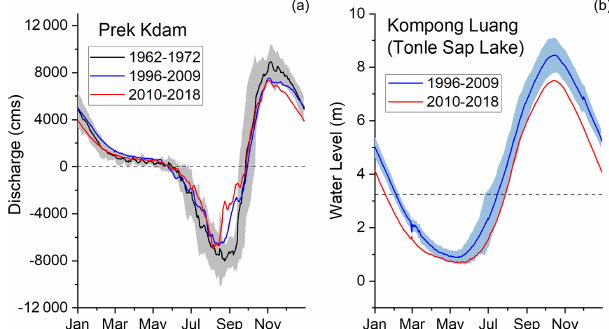
Figure 5. (a) Change in discharge at Prek Kdam over time. Shaded region indicates standard error of mean discharge during 1962– 1972. (b) . Change in water level at Kampong Luang over time. Shaded region indicates standard error of mean water level during